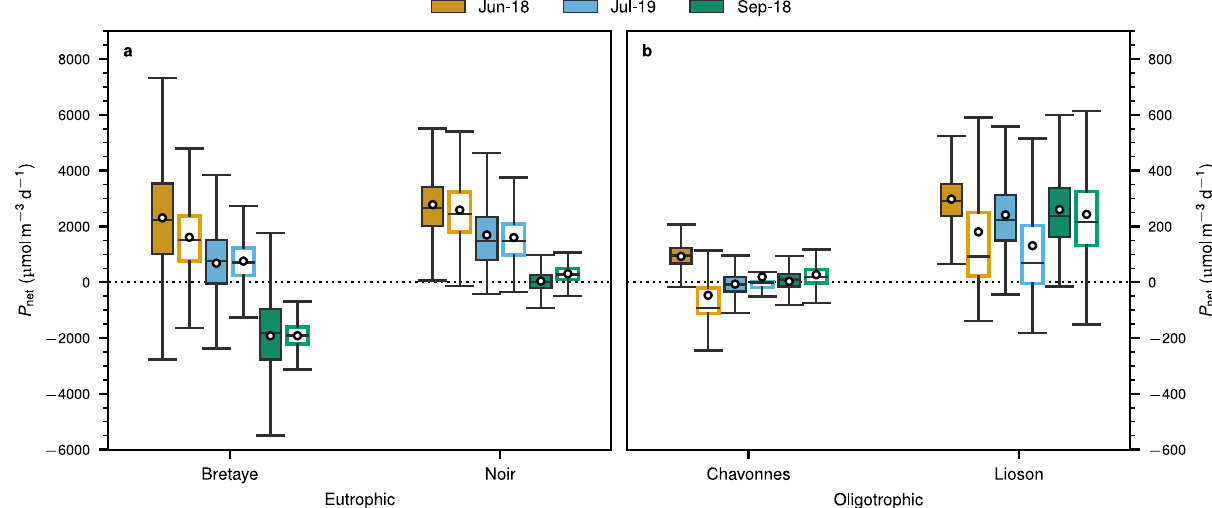
Fig. 3 | P net rates estimations in the surface mixed layer of each lake using two approaches. The full-scale mass balance ( P net,fs ; fi lled boxes) and lateral transport model ( P net,lt ; open boxes). The lakes were divided as a eutrophic and b oligotrophiclakes.Boxesshowthe fi rstandthirdquartileswiththemedian(line),